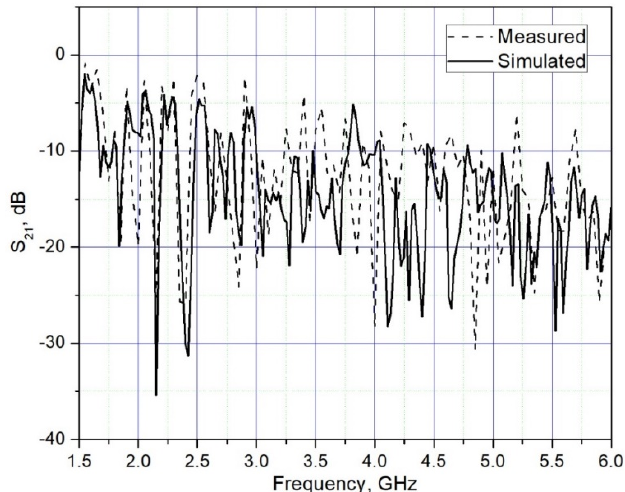
Figure 7 . S 21 measured and simulated results of brick sample in a frequency range 1.5 to 6 GHz, (d = 18 mm; 2r = 150 mm) .